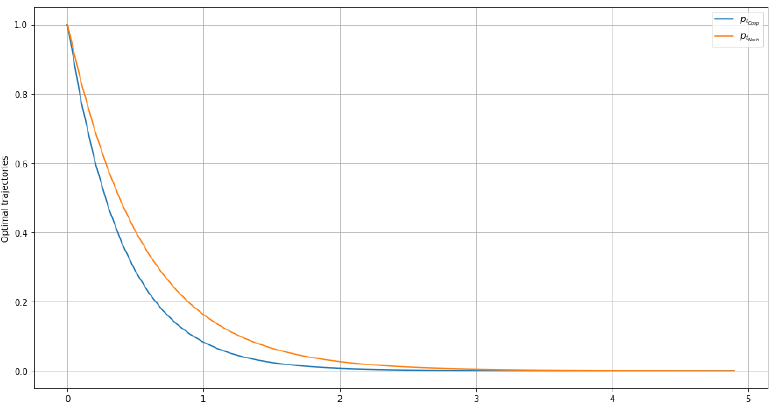
Figure 2. The optimal trajectory of pollution stock under cooperation VS Nash equilibrium.